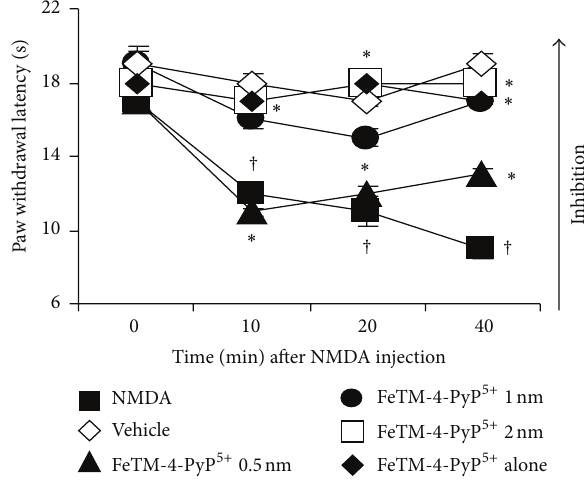
Figure 1: Intrathecal injection of NMDA (2nmol, ◼ ) causes thermal hyperalgesia when compared to vehicle ◊ , and this response is blocked by FeTM-4-PyP 5+ in a dose-dependent manner (0.5nmol ( 󳵳 ), 1nmol ( ∙ ), and 2nmol ( ◻ ), given intrathecally 15 min before NMDA). Intrathecal injection of FeTM-4-PyP 5+ alone ( ⧫ , 2 nmol) did not exert any effect. Results are expressed as mean ± SEM for 8 rats; † 𝑃 < 0.001 compared to vehicle and ∗ 𝑃 < 0.001 compared to NMDA